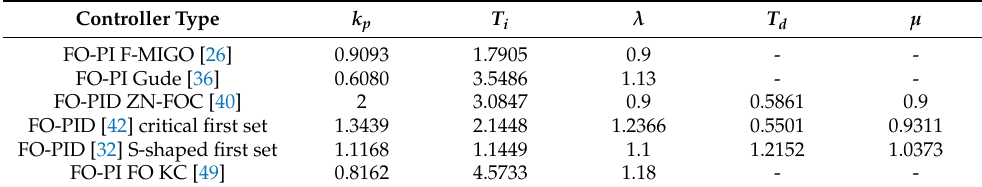
Table 4. FO-PID parameters computed for the higher order process. Controller